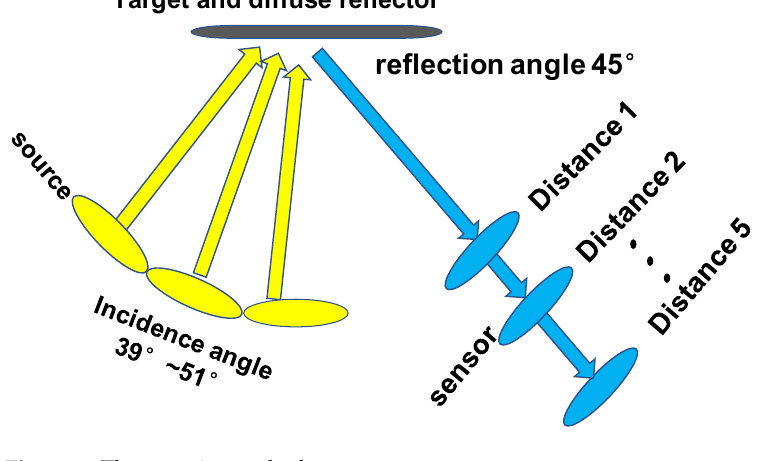
Figure 7. The experimental scheme.